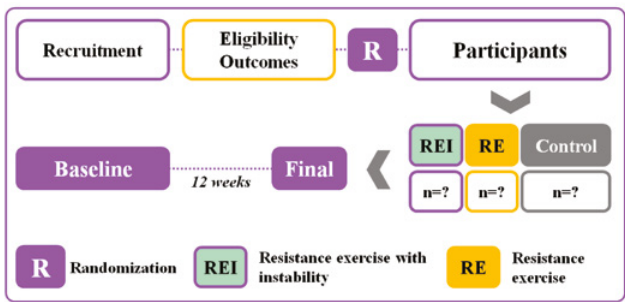
Figure 1. Experimental design and timeline of REI